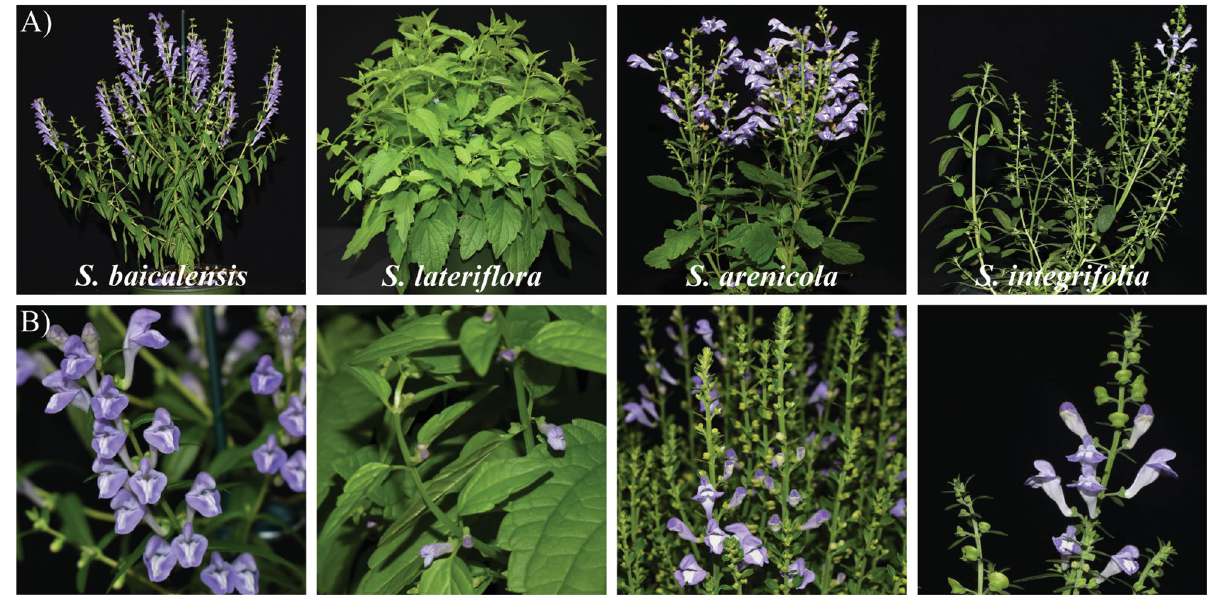
Figure 1. Morphology of the Scutellaria species used in this study. Characteristic features of the Lamiaceae family including angular stems, simple opposite leaves, and lobed flower petals. ( A ) plant growth habit and ( B ) flower morphology and size variations observed from the species in ( A